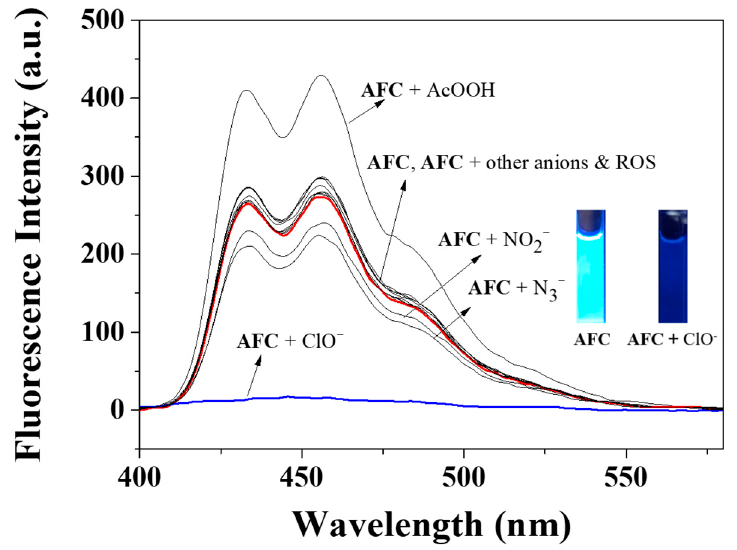
Figure 1. Fluorescent variations of AFC (1 × 10 − 5 M) with various anions (290 equivalents).